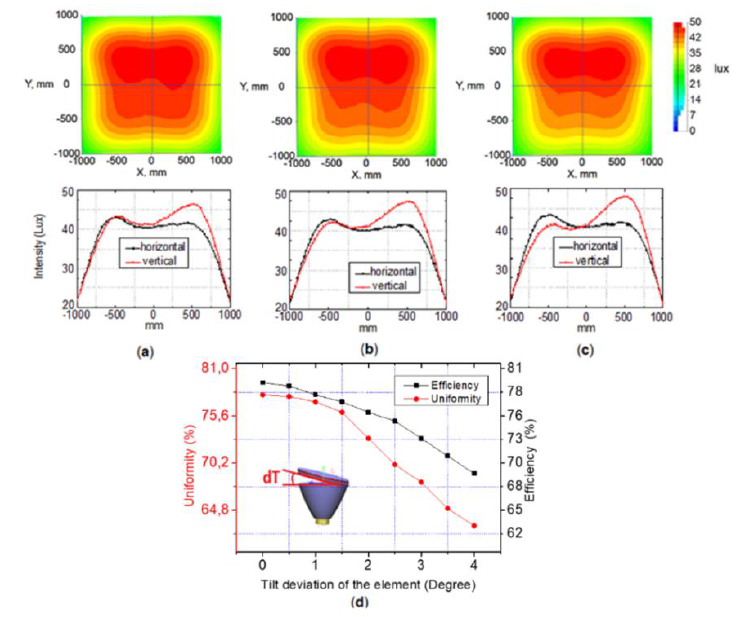
Figure 10. Light distribution on a receiver with ( a ) dT = 2°; ( b ) dT =3°; and ( c ) dT =4°. ( d ) Efficiency and uniformity depend on deflection angle dT .